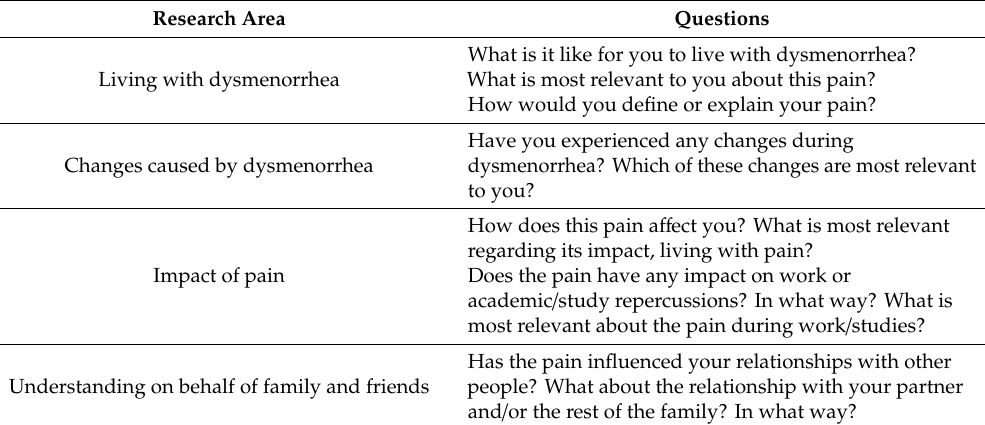
Table 3. Semi-structured focus group question